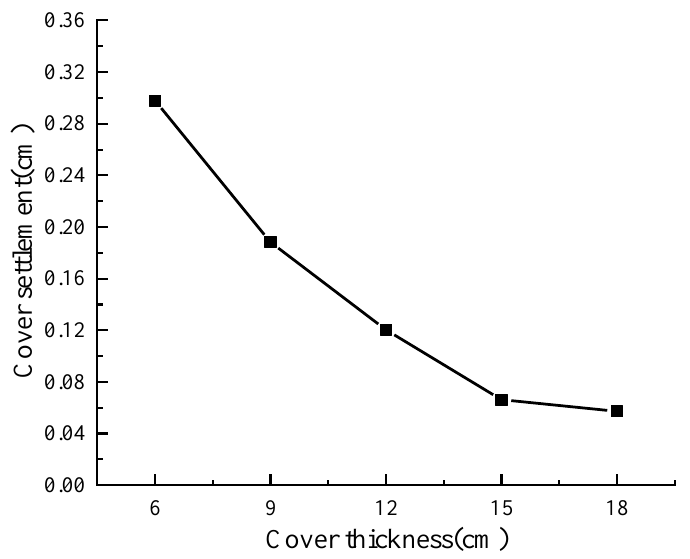
Figure 7. Rising water table cover settlement. Figure 7. .Rising water table cover settlement.